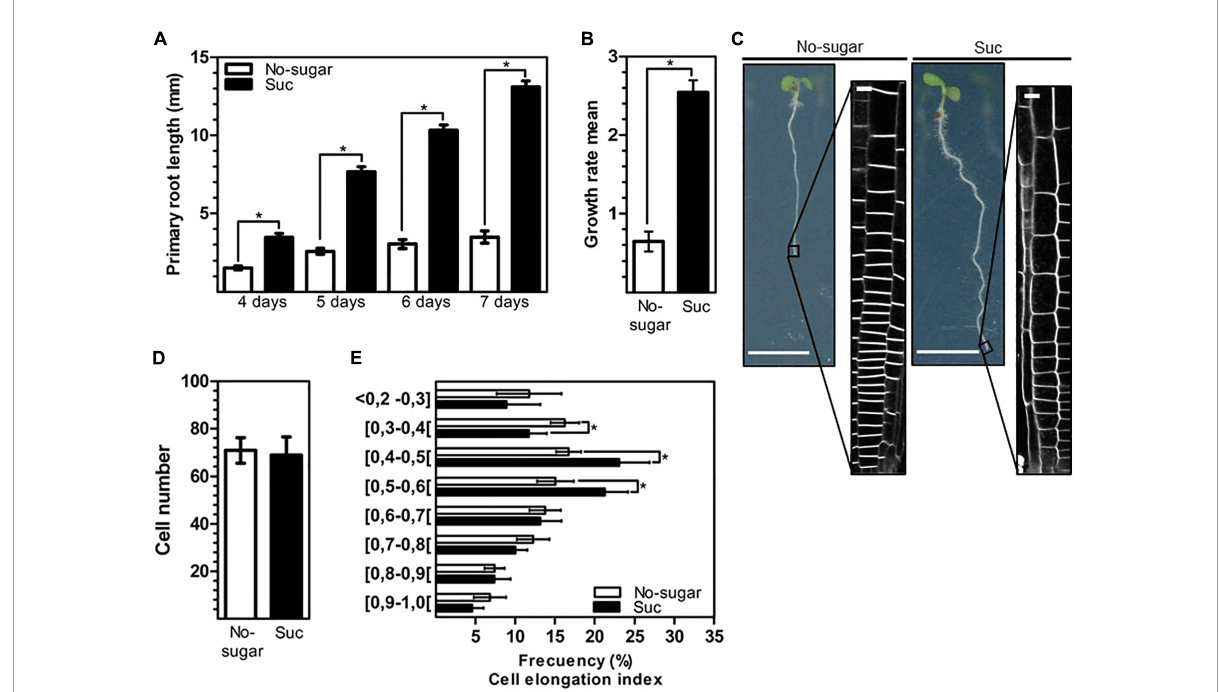
FIGURE1 Elongation of root epidermal cells is promoted by sucrose. Wild-type Arabidopsis (Col-0) seeds were sown on solid medium without sugar (No-sugar, white bar) or supplemented with 60 mM sucrose (Suc, black bar) and grown for several days. (A) Primary root length of seedlings was measured in n ≥ 20 seedlings per replicate. (B) Growth rate per day of seedling roots from day 4 to day 7 in (A) . (C) Epidermal cells at the root tip were visualized by plasma membrane FM4-64-staining of seedlings after 7 days. Representative image of seedlings in each condition are shown. Bar: 5 mm. Representative confocal images are shown ( n ≥ 20 seedlings under each condition). Bar, 10 µ m. (D,E) Cell height and width were measured for epidermal cells located up to 300 µ m above the quiescent center of the primary root of seedlings in (B) . The ratio of cell height/width was considered the cell elongation index. (D) The number of meristematic cells (ratio height/width ≤ 1) of the seedling primary root in (B) was scored. (E) The number of meristematic cells is shown as the percentage of cells that display a range of cell elongation index values. n ≥ 15 seedlings were scored in either condition. (A,B,D,E) Error bars represent standard error for three independent biological replicates. Student’s t -test; * p <